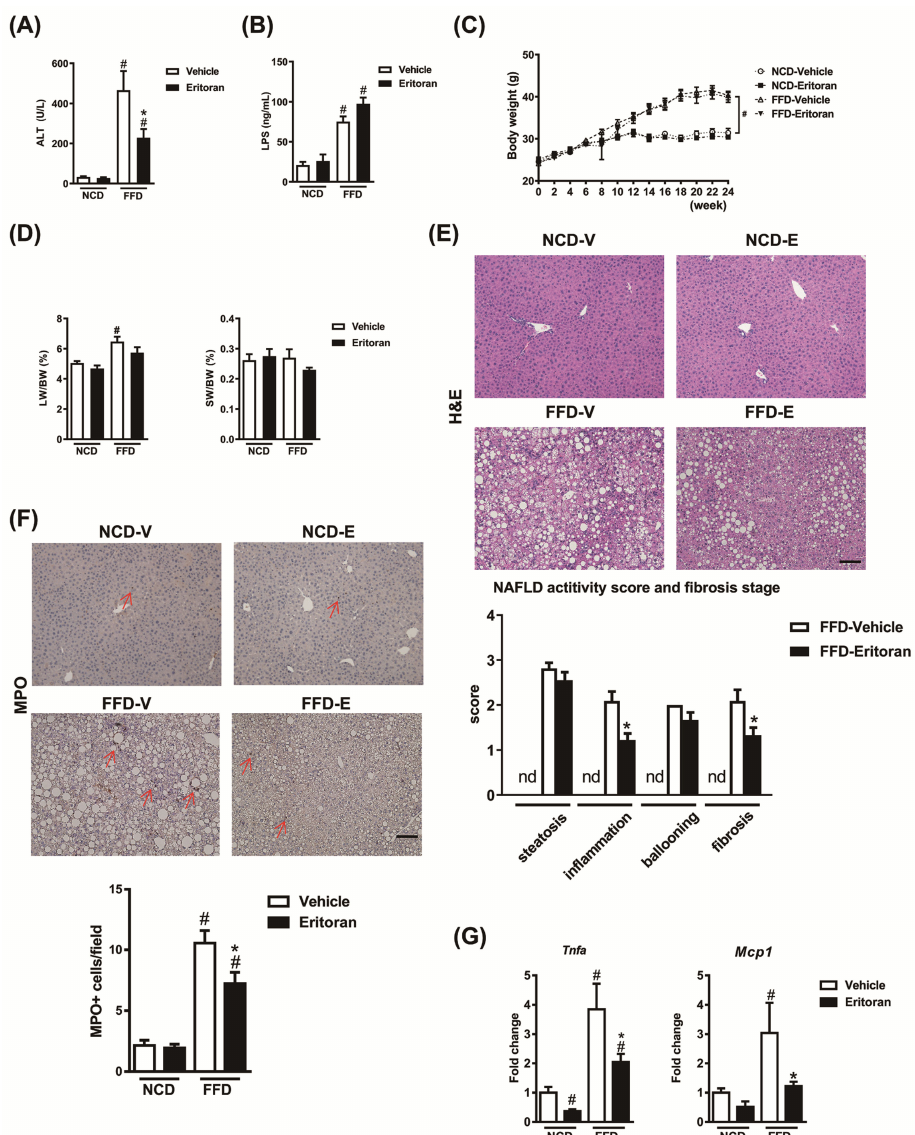
Figure 2. Eritoran reduced hepatic inflammation in the mice fed a fast-food diet. ( A ) Serum alanine aminotransferase (ALT) levels. ( B ) Serum lipopolysaccharide (LPS) levels. ( C ) Body weight (BW), ( D ) liver weight (LW) and spleen weight (SW). ( E ) Hematoxylin and eosin (H&E) and ( F ) myeloper- oxidase (MPO) staining of the liver sections and quantification of NAFLD activity scores as well as MPO-positive stained cells (arrow). Scale bar = 100 µ m; nd: non-detectable. ( G ) Hepatic transcript levels of tumor necrosis factor- α ( Tnfa ) and monocyte chemoattractant protein 1 ( Mcp1 ). NCD- V/NCD-E: the mice fed a normal chow diet (NCD) were injected with a vehicle (NCD-V, n = 6) or eritoran (NCD-E, n = 6); FFD-V/FFD-E: the mice fed a fast-food diet (FFD) were injected with a vehicle (FFD-V, n = 10) or eritoran (FFD-E, n = 9); # p < 0.05 vs. NCD-V; * p < 0.05 vs.